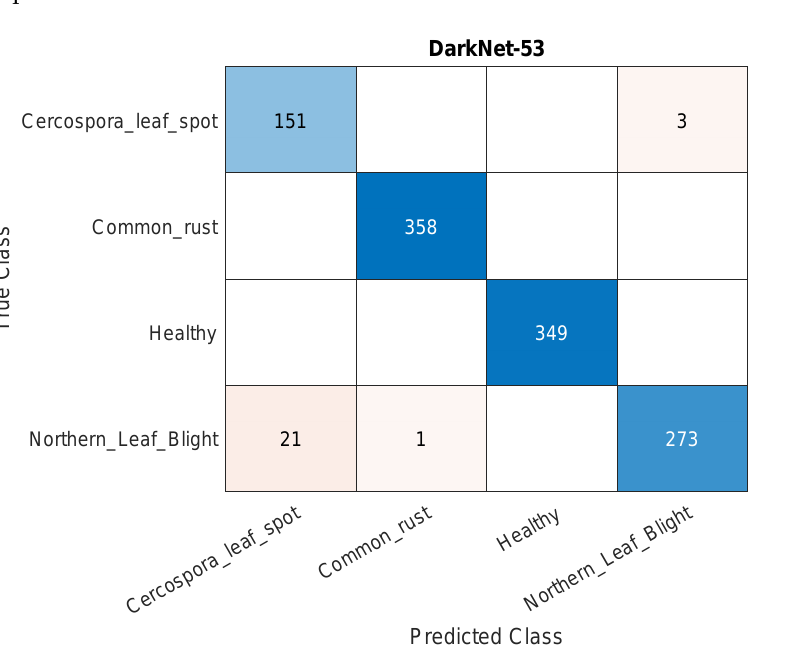
Figure 5. A sample confusion matrix for the DarkNet-53 model and using 70% of the data for training.